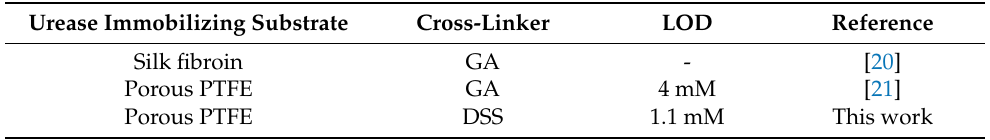
Table 2. Comparison of limits of detection (LODs) of biosensors that monitor the urea concentration in flow conditions. Listed LOD was measured at a flow rate of 1.0 mL /